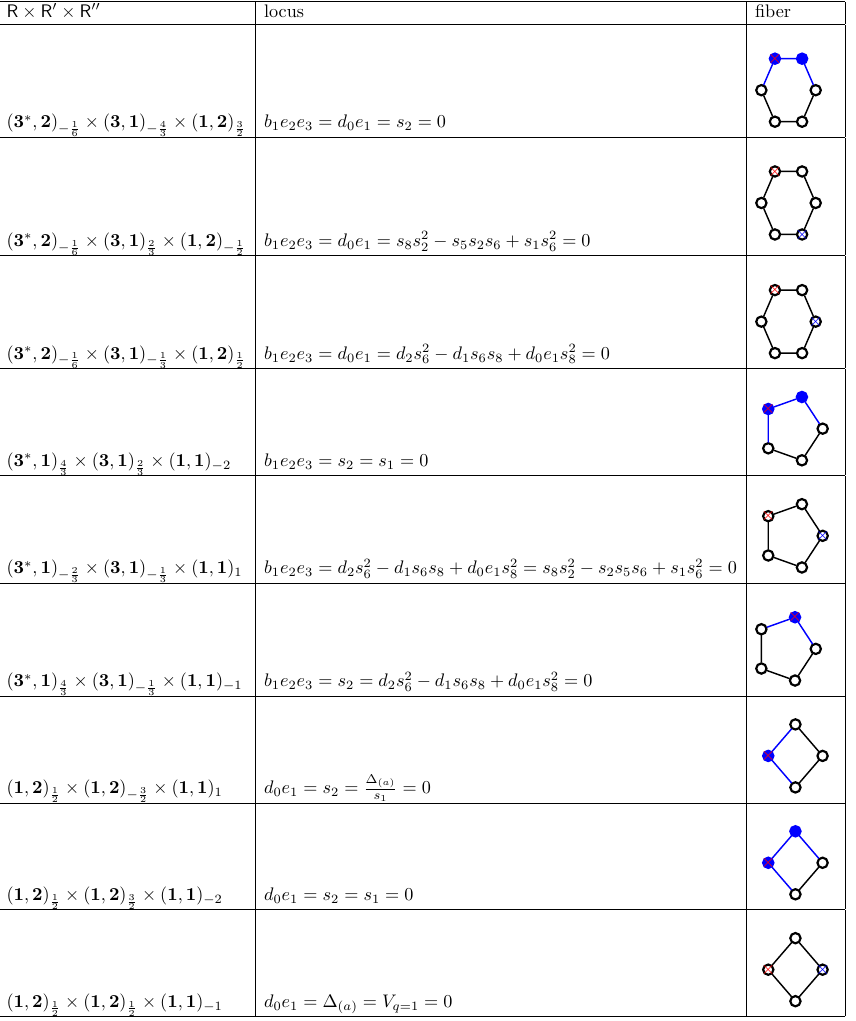
Table 2 . Table of singular elliptic fibers of the resolution X 5 → X 0 of the (SU(3) × SU(2) × U(1)) / Z model over codimension-three components of the discriminant locus ∆ = 0 ; these singular 6 fibers correspond to Yukawa interactions. The left-most column describes the triples of chiral representations that are contracted to gauge-singlets in each Yukawa interaction. See the caption of table 1 for an explanation of the graphs in the right-most column and the definitions of the singular